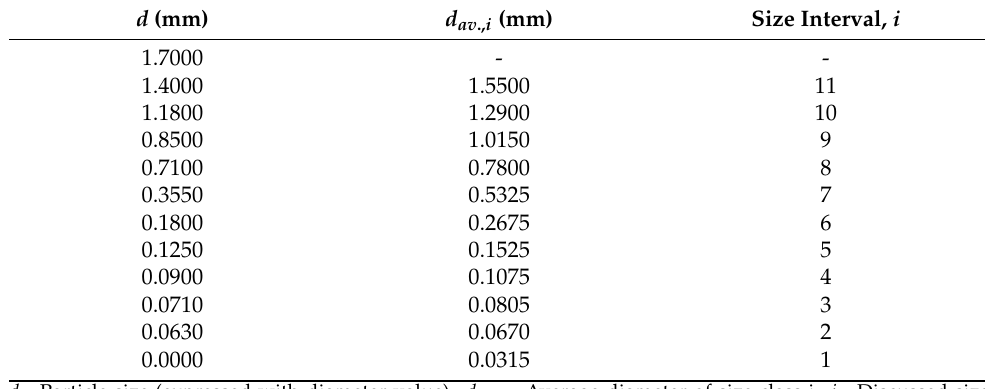
Table 1. Used size intervals,